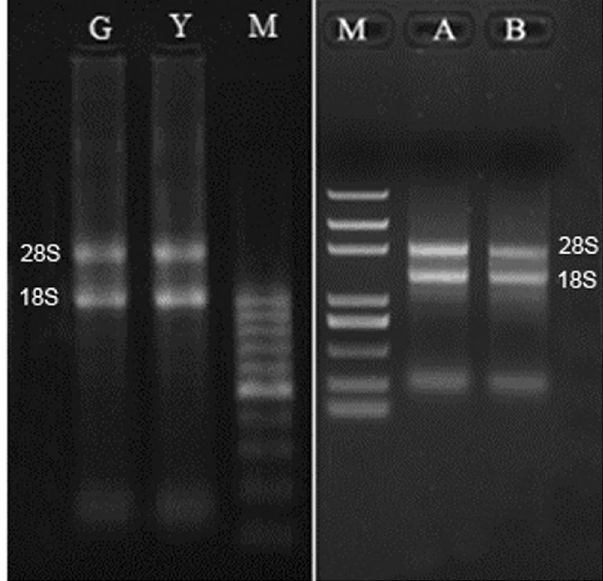
Figure 1. Total RNA bands on the gel by electrophoresis. M: Marker. G: fundatrigenia. Y: overwintering aphid. A: overwintering aphid reared at constant 18 °C. B: overwintering aphid reared at constant 7.5